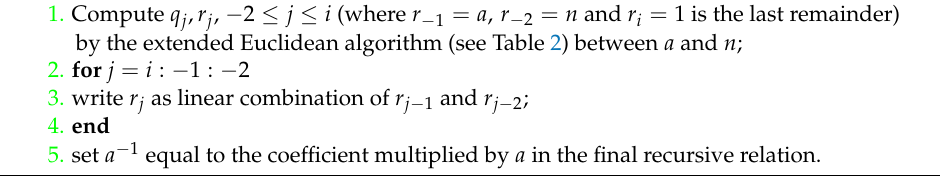
Table 3. Pseudocode of the inverse modulo n (through the extended Euclidean